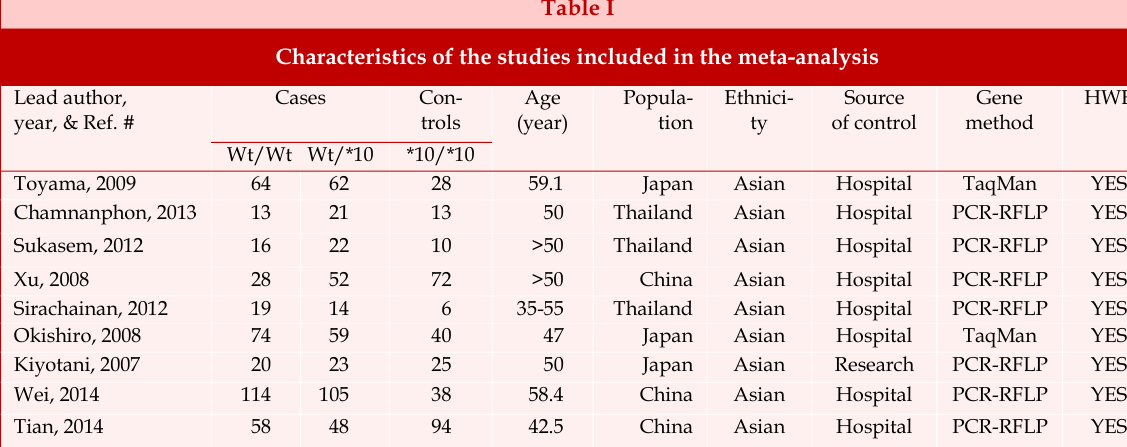
Characteristics of the studies included in the meta-analysis Cases